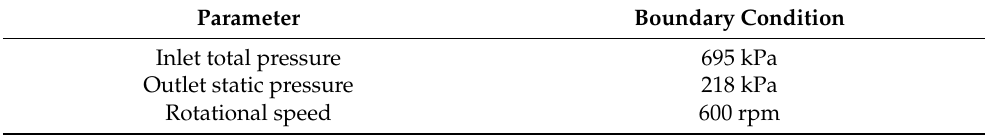
Table 3. Experimental parameters used as boundary conditions in the